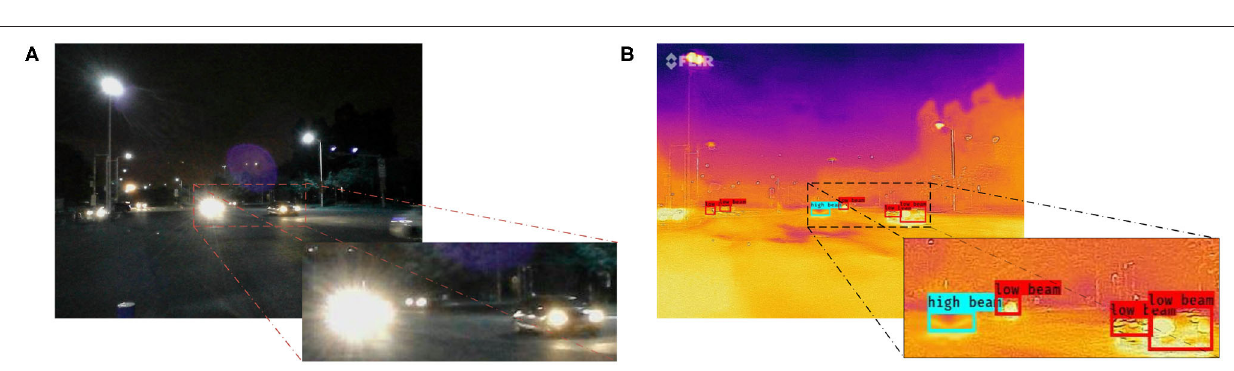
FIGURE 15 | Results of distinguishing. (A) A Red Green Blue (RGB) original image. (B) A result image with distinguishing.